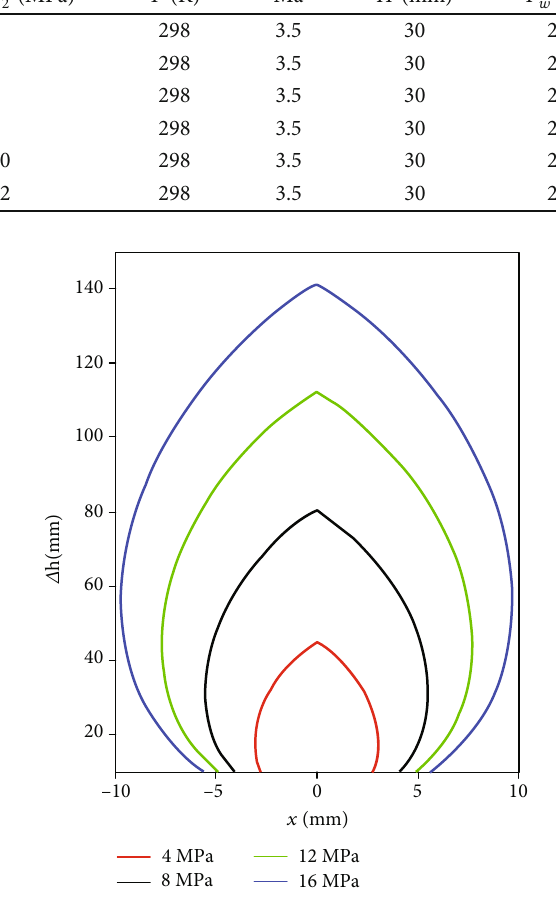
Figure 6: Characteristics of erosion pit under di ff erent jet conditions. Table 2: Pressure at pipeline inlet under di ff erent jet pressures.